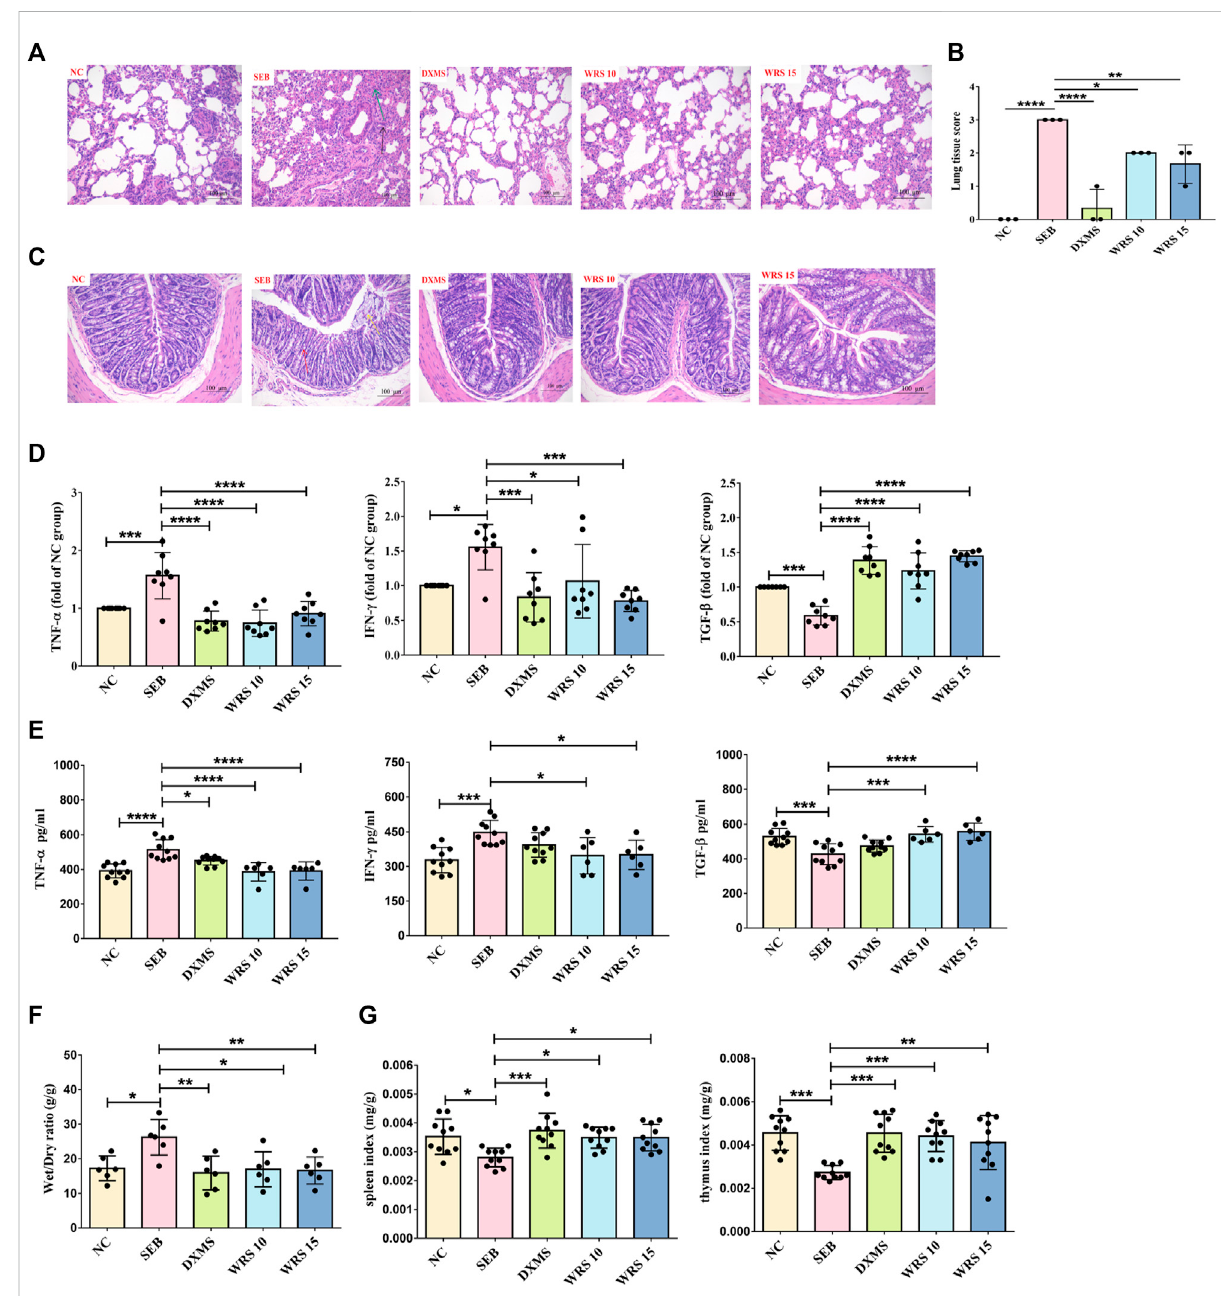
FIGURE 1 WRS reduces symptoms and in fl ammation associated with ARDS. (A) The pathological changes of paraf fi n sections of lung tissues were measured by H&E staining. Scale = 200 μ m. (B) Lung tissue injury scores among groups ( n = 3). (C) The pathological changes of paraf fi n sections of colontissues weremeasuredbyH&E staining.Scale =200 μ m. (D) Levelsof threecytokinesfromthelung tissue ( n = 8). (E) Levelsofthree cytokines from the serum ( n = 6 – 10). (F) The lung wet/dry ratio ( n = 6). (G) The organ index of spleen and thymus ( n = 10). Data have been presented as means ± SD. Statistical analysis was carried out using one-way ANOVA. * p < 0.05, ** p < 0.01, *** p < 0.001, **** p <